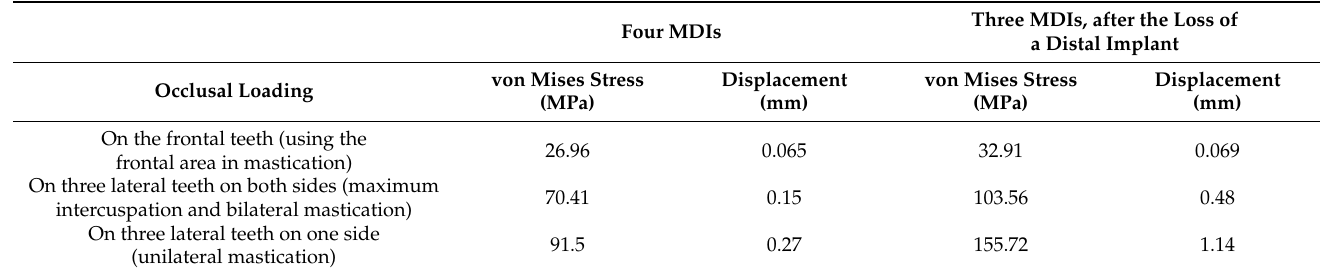
Figure 7. The von Mises stresses and displacements generated by the unilateral loading of an overdenture on four interforaminally inserted MDIs ( top ), compared to the loss of a distal implant ( bottom ). Table 1. Biomechanical changes in the conditions of loss of a distal implant for the mandibular overdenture on four interforaminally inserted